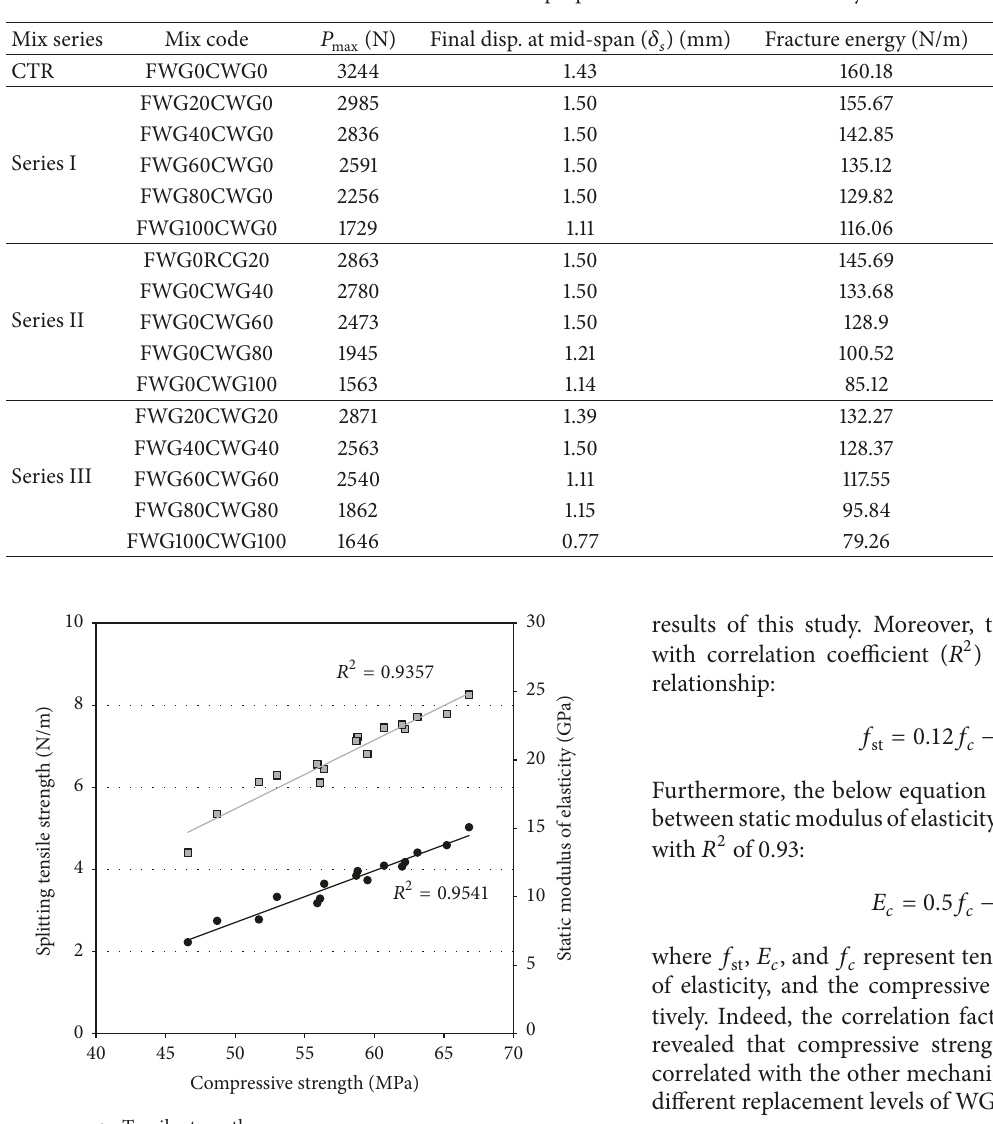
Table 4: Fracture properties of PW concrete at 28 days.